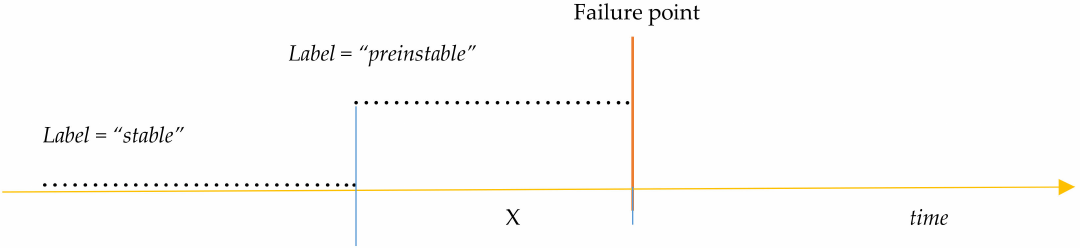
Figure 10. Data classification and label construction—adapted from